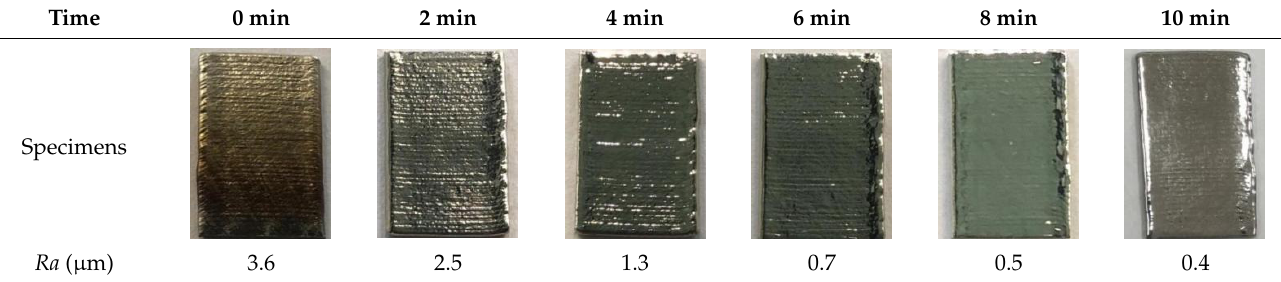
Table 6. Specimen images and surface roughness at different time points.